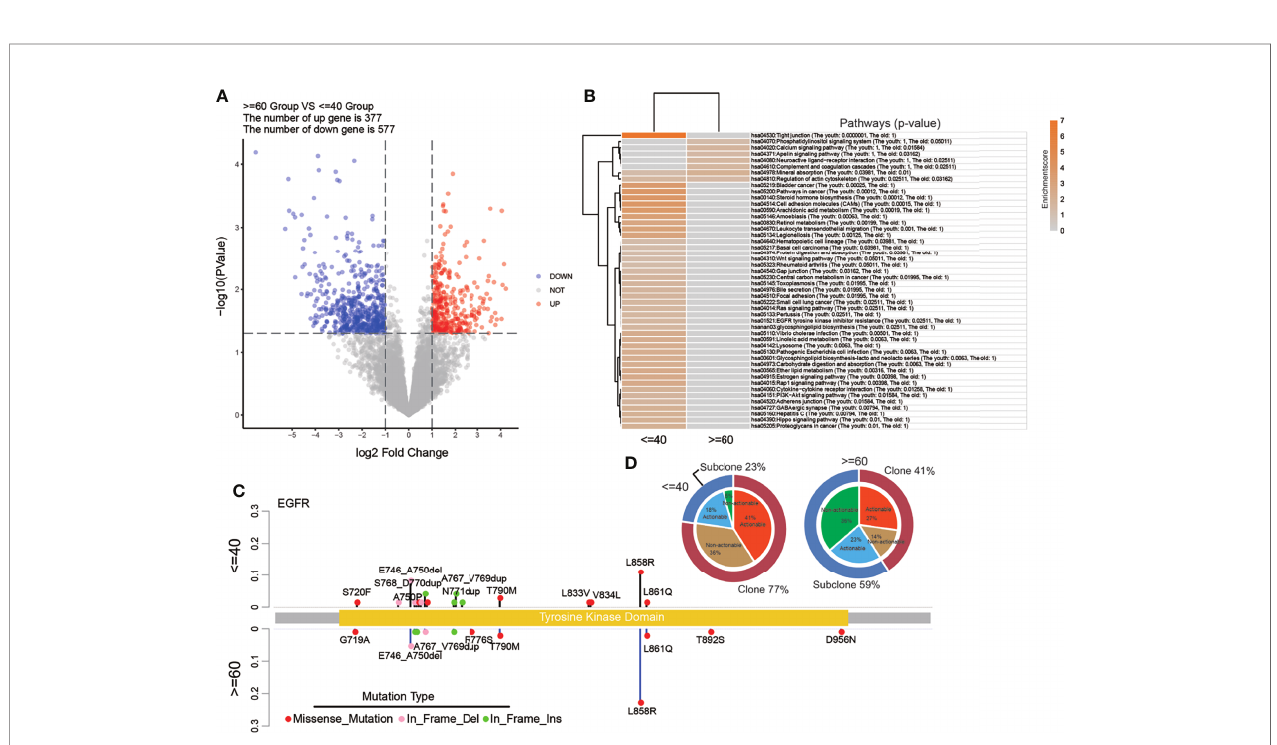
FIGURE 6 | Pathway analysis with RNA data from CCLE and detailed EGFR mutation status of the 165-sample cohort. (A) The volcano plot of CCLE RNA data showing the differentially expressed genes. (B) Pathways that signi fi cantly enriched in two groups with CCLE RNA data. (C) The lollipop plot showed the distribution of EGFR mutation types. (D) The clonality and actionability of EGFR alterations in the 165-sample